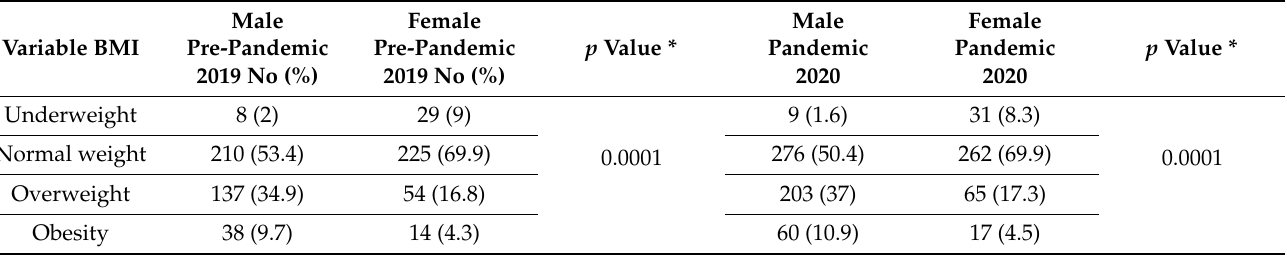
Table 1. Body mass index categories for IT workers.